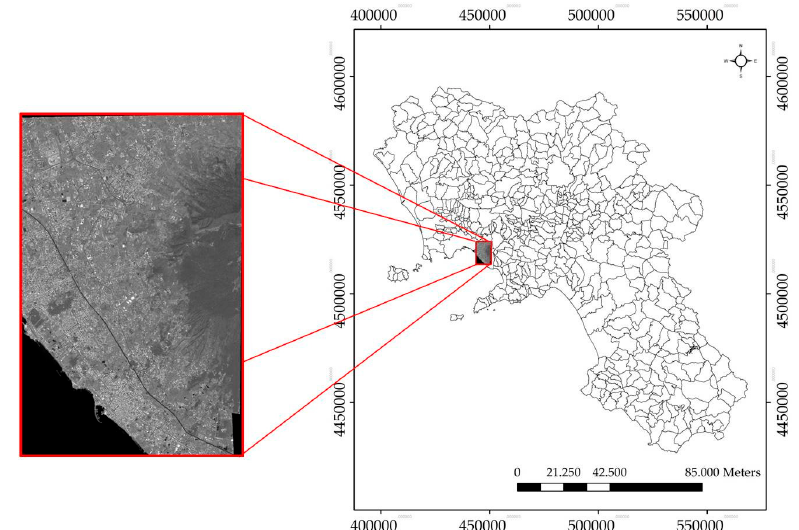
Figure 1. WorldView-2 (WV-2) image and its location in Campania. The coordinates reported on the map are referred to as UTM/WGS84 (33 N—zone T) and expressed in meters.